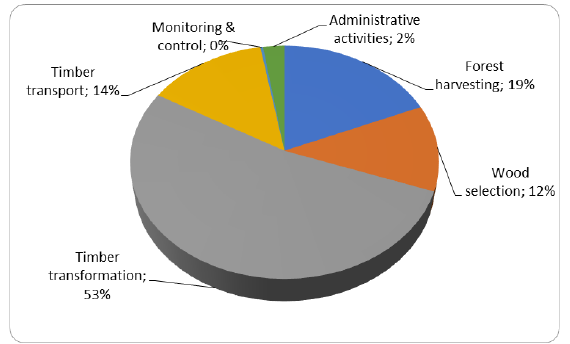
Figure 4. CO 2 emissions by types of actions.